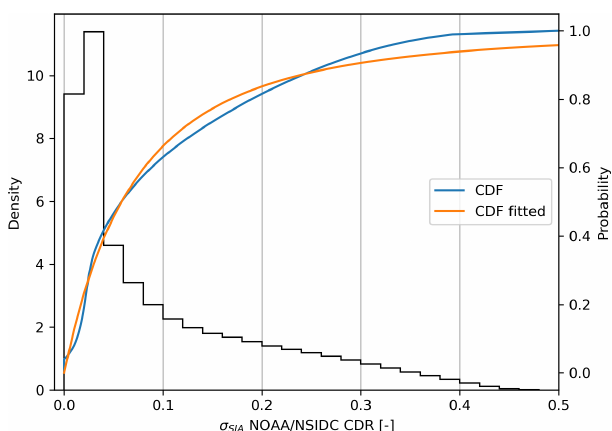
Figure 2. Empirical probability (black line) and cumulative (blue line) density functions of the σ SIA indicator from the NOAA/N- SIDC CDR dataset. The orange curve is the fitted Pareto distribu-